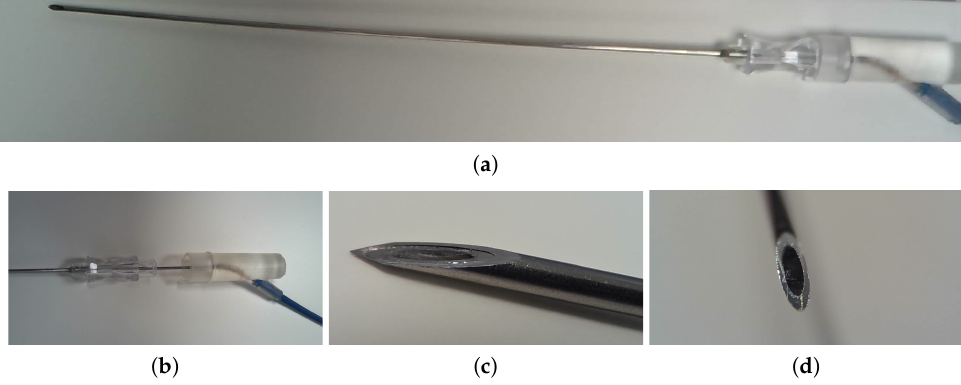
Figure 2. Photographs of the needle with integrated FOH: ( a ) needle assembly, with the stylet fully inserted into the cannula; ( b ) stylet partially inserted into the cannula; ( c ) the tip of the needle, with the stylet fully inserted; ( d ) the tip of the